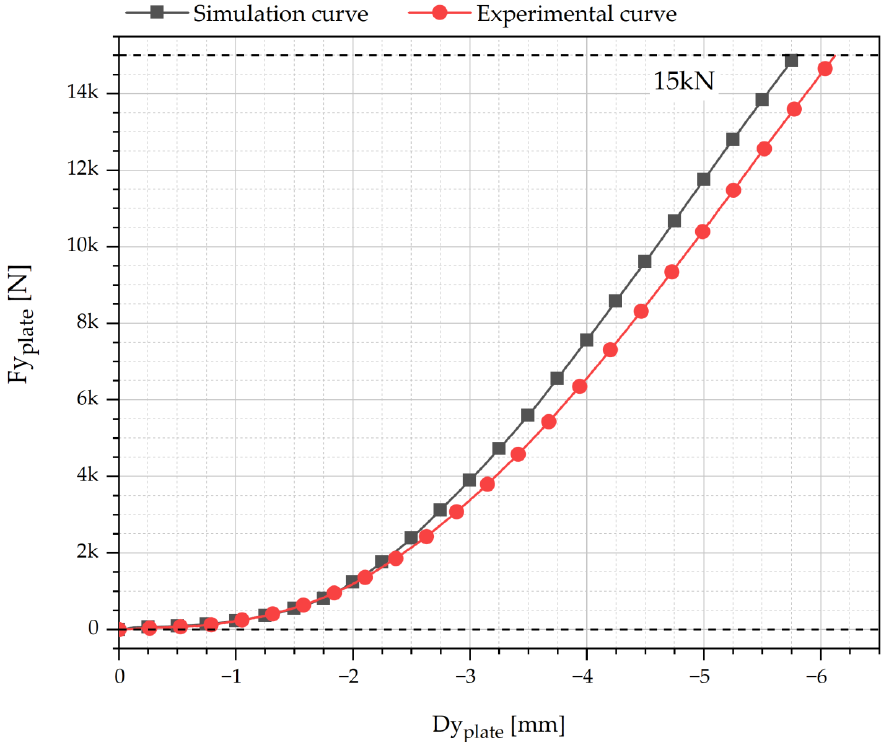
Figure 16. Comparison of the compression behavior of the tested and simulated toe